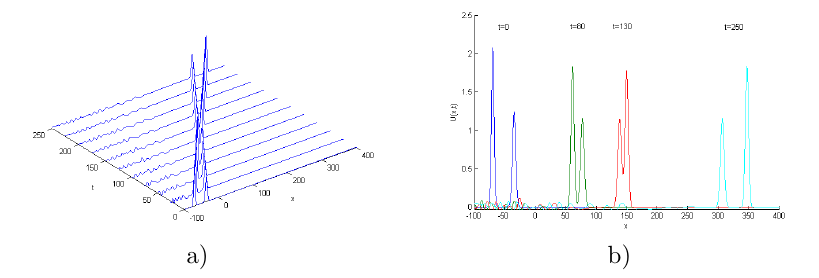
Figure 3. Two solitary waves for a = b = c = 1, d = 0 . 5, h = ∆t = 0 . 1, v 1 = 0 . 3 , v 2 = 0 . 5, x 1 = − 70 and x 2 = − 35: a) profiles of waves, b) interaction of waves at specified times.